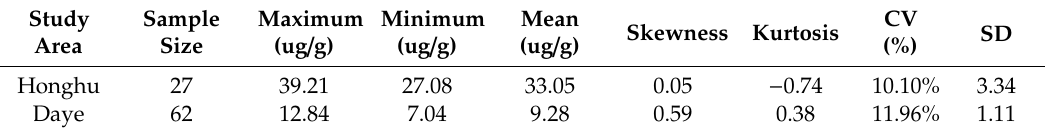
Table 1. Statistical characteristics of soil samples.